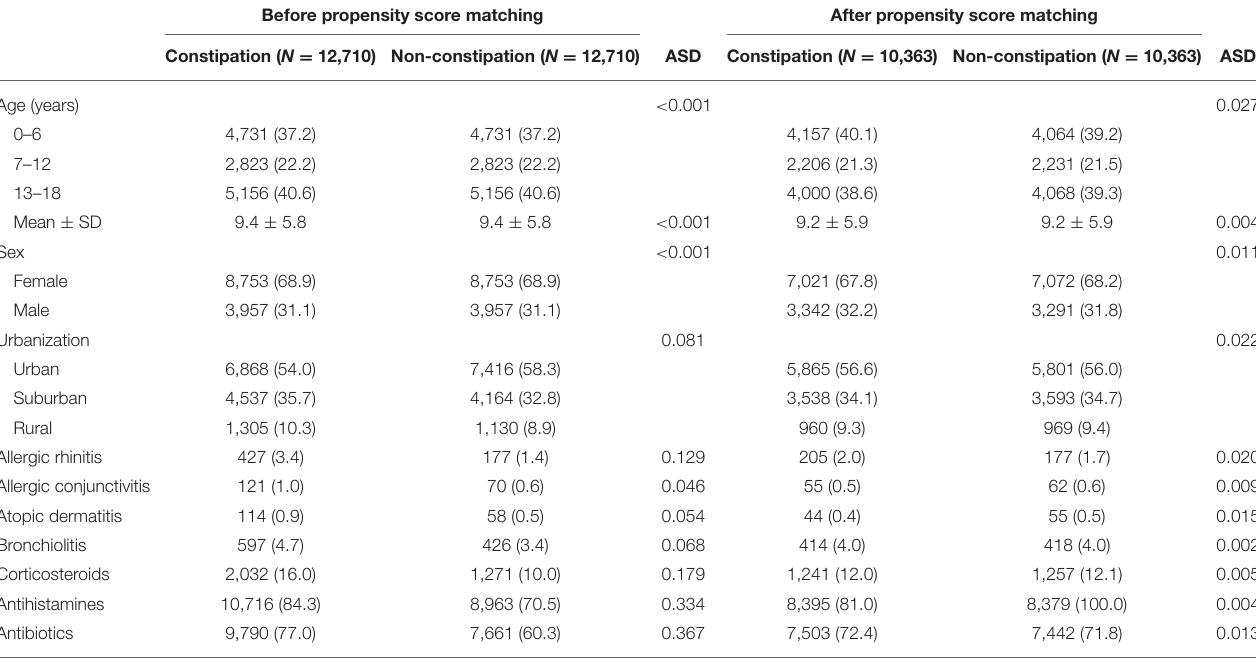
TABLE 1 | Demographic characteristics of the constipation group and non-constipation group. Before propensity score